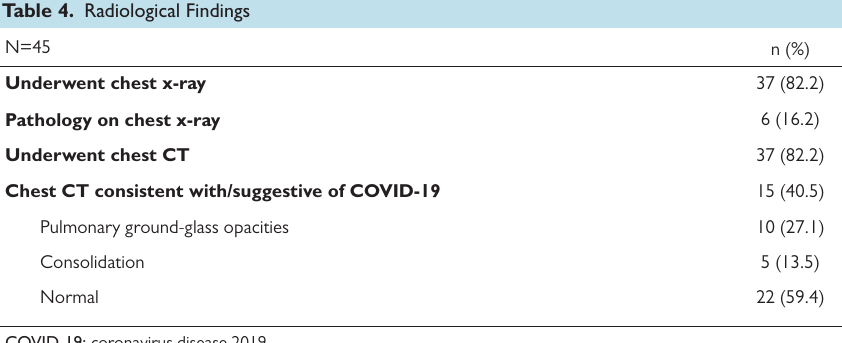
Table 4. Radiological Findings N=45 Underwent chest